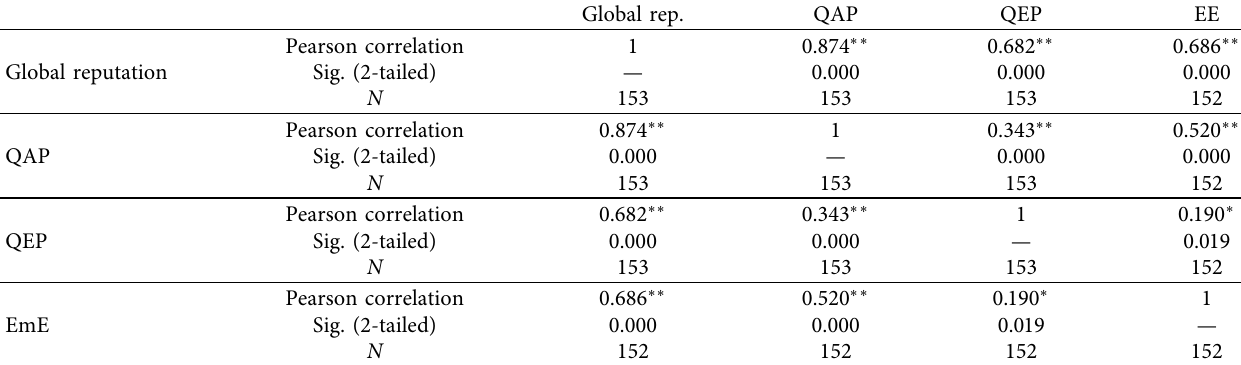
Table 4: Correlations between facets of